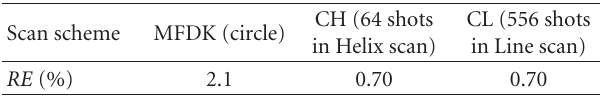
Table 3: RE (%) of the numerical breast phantom among MFDK, CH, and